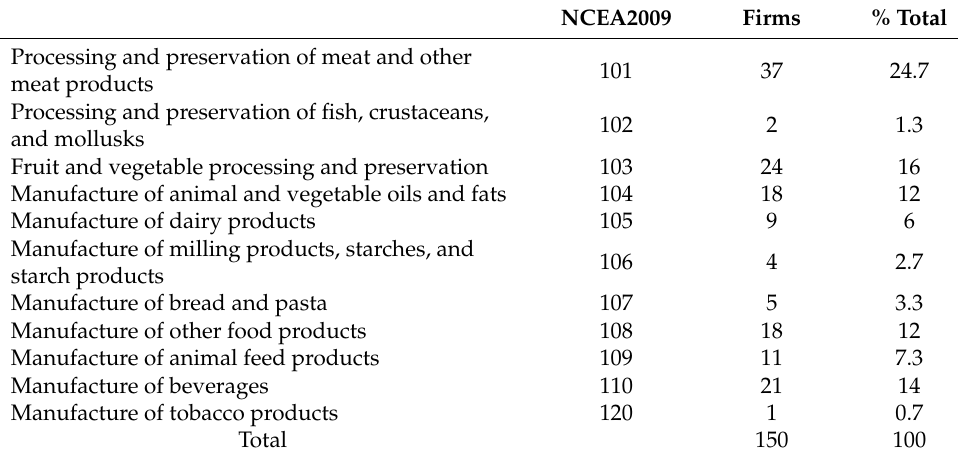
Table 2. Branches of